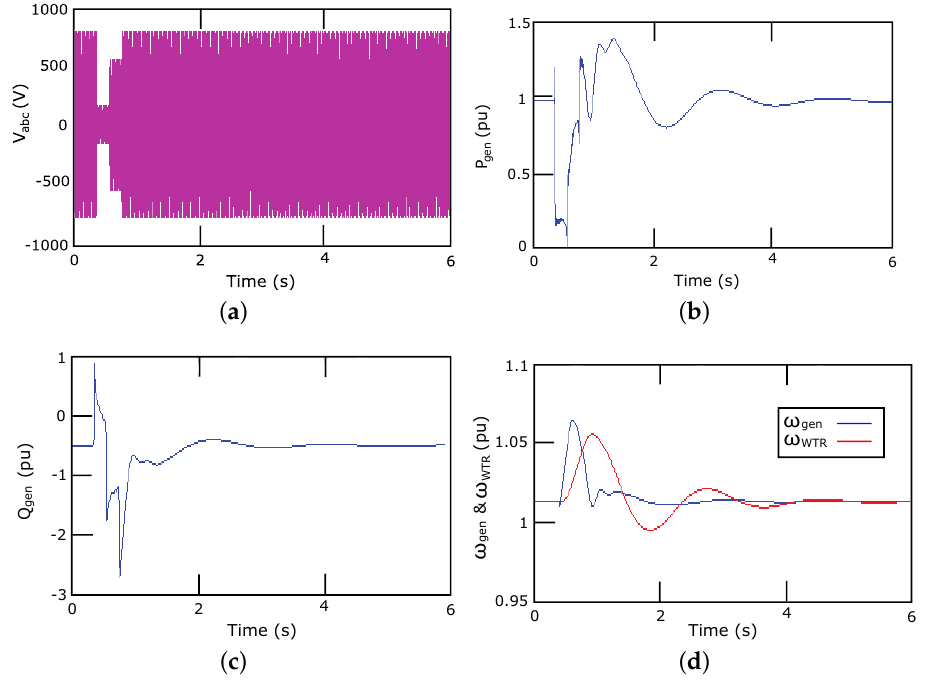
Figure 18. Response of Type 1A WT ( a ) Voltage dip ( b ) Generator active power ( c ) Generator reactive power ( d ) Generator and turbine rotational speeds.